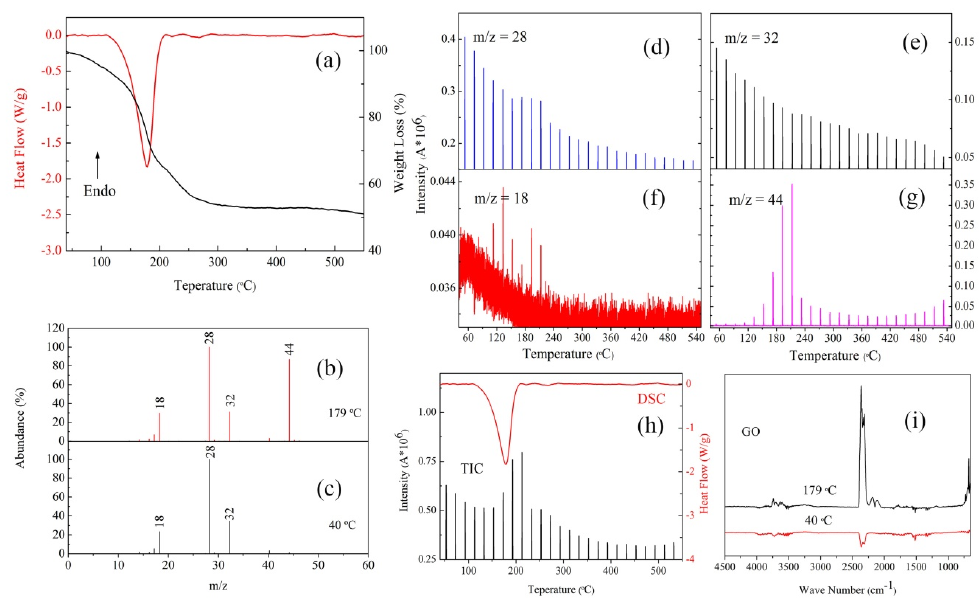
Figure 8. ( a ) DSC and TG curves of nGO with heating rate of 10 °C/min; the MS spectra of nGO at ( b ) 179 °C and ( c ) 40 °C; the ion current spectra of nGO in the decomposition with ( d ) m/z = 28, ( e ) m/z = 32, ( f ) m/z = 18, ( g ) m/z = 44, ( h ) total ion current; ( i ) IR spectra of nGO at 179 °C and 40 °C.